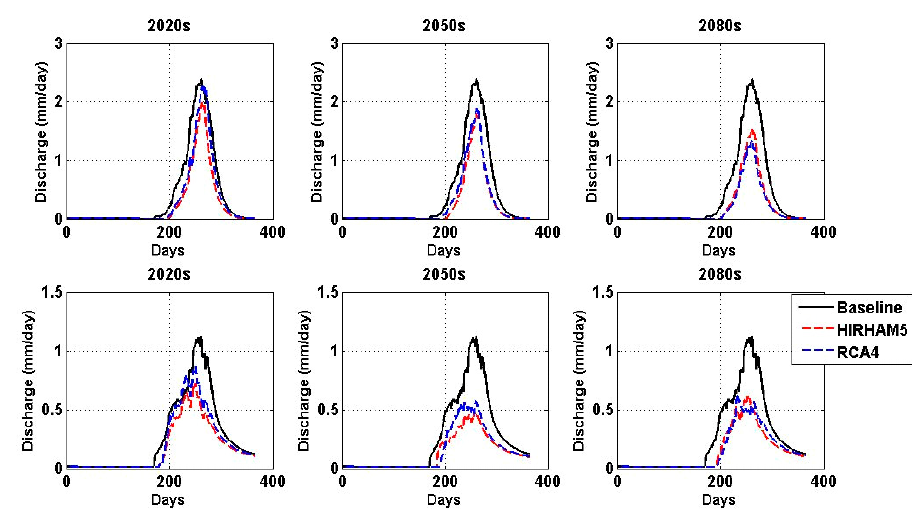
Figure 9. Average hydrographs for HIRHAM5 and RCA4 projections for the 2020s, 2050s and 2080s time horizons and the 1961–1990 baseline for the Bétérou catchment ( top ) and Bonou catchment ( bottom ) derived from RCP4.5 scenarios.